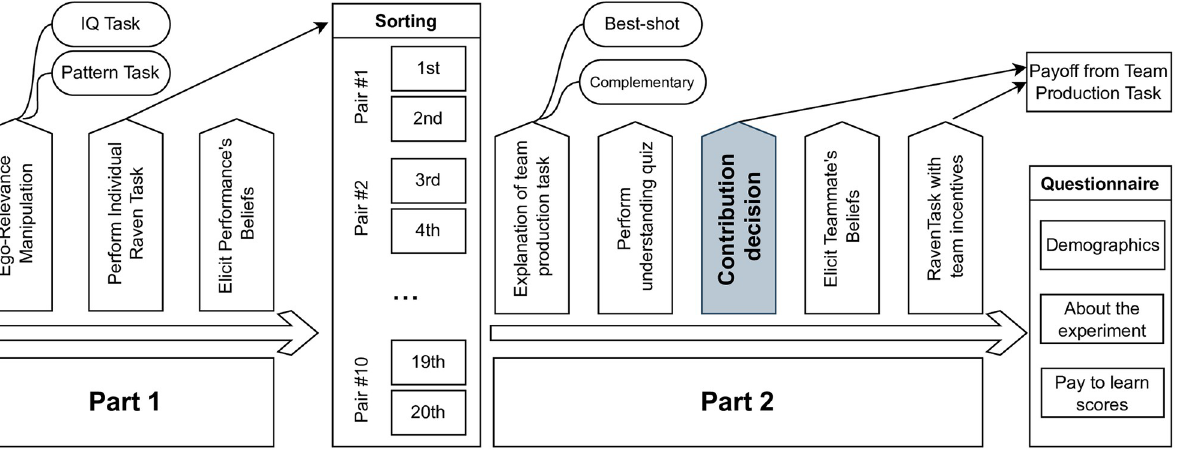
Fig 1. Timeline of steps within each part of the